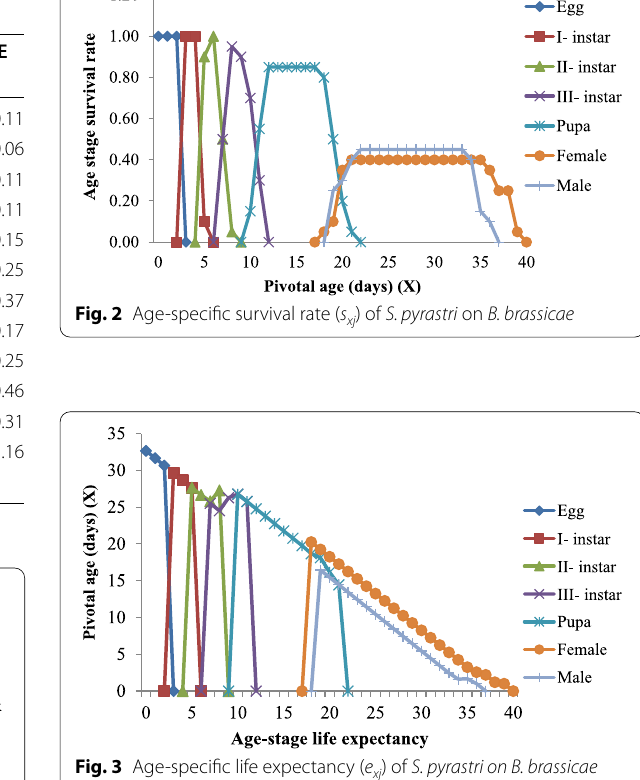
Table 1 Developmental biology of S. pyrastri on cabbage aphid,